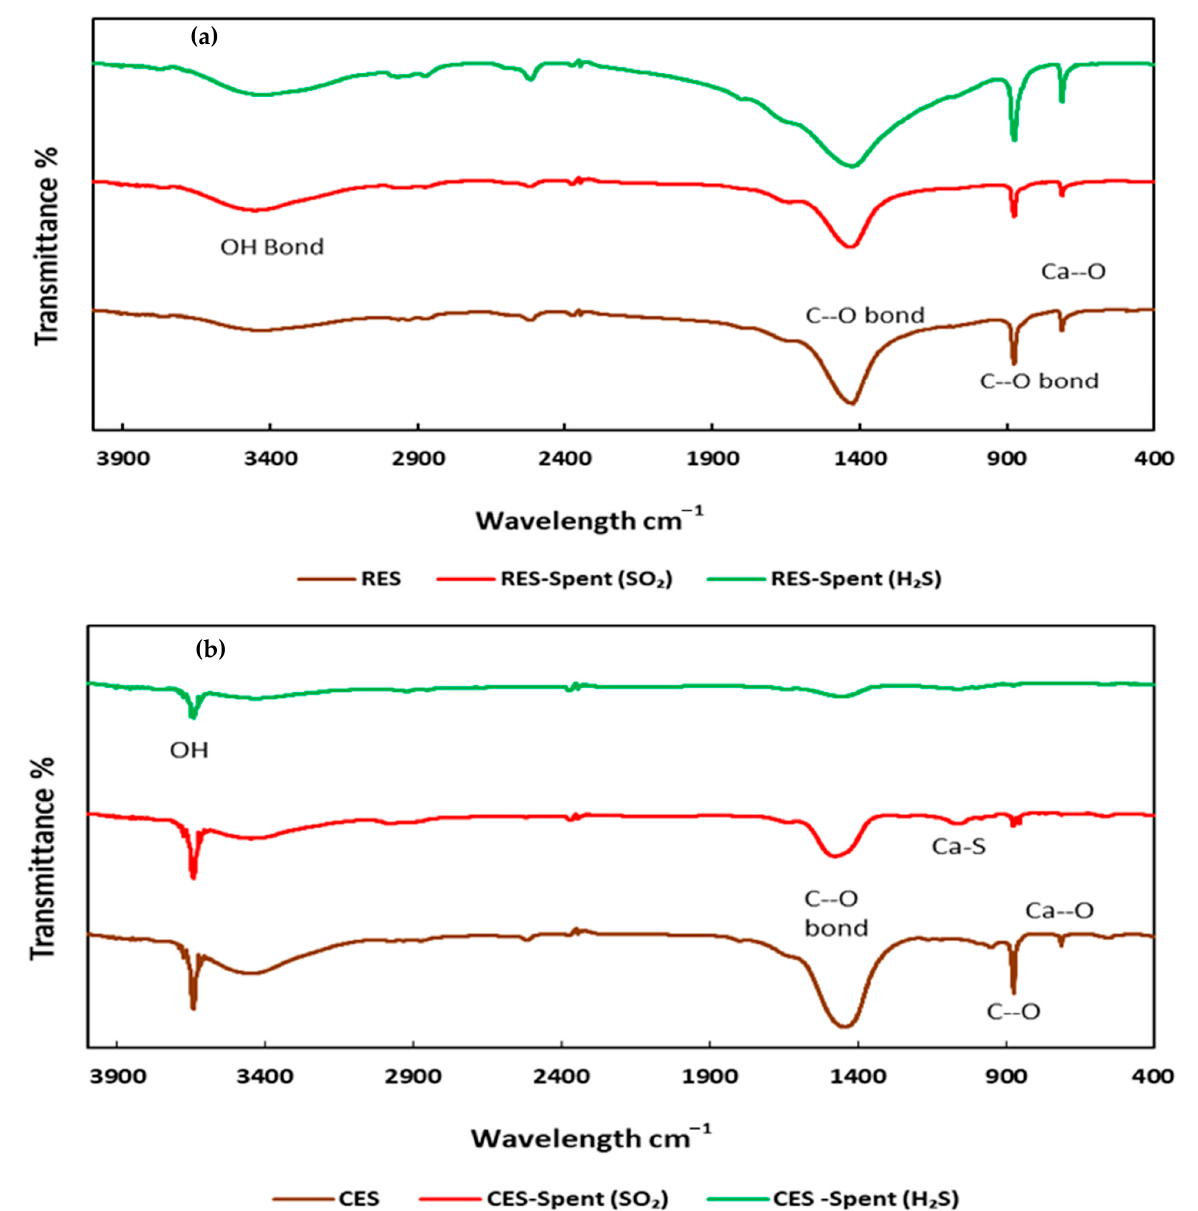
Figure 4. FTIR spectra of ( a ) raw eggshell and ( b ) calcined eggshell (900 °C) before and after adsorption.